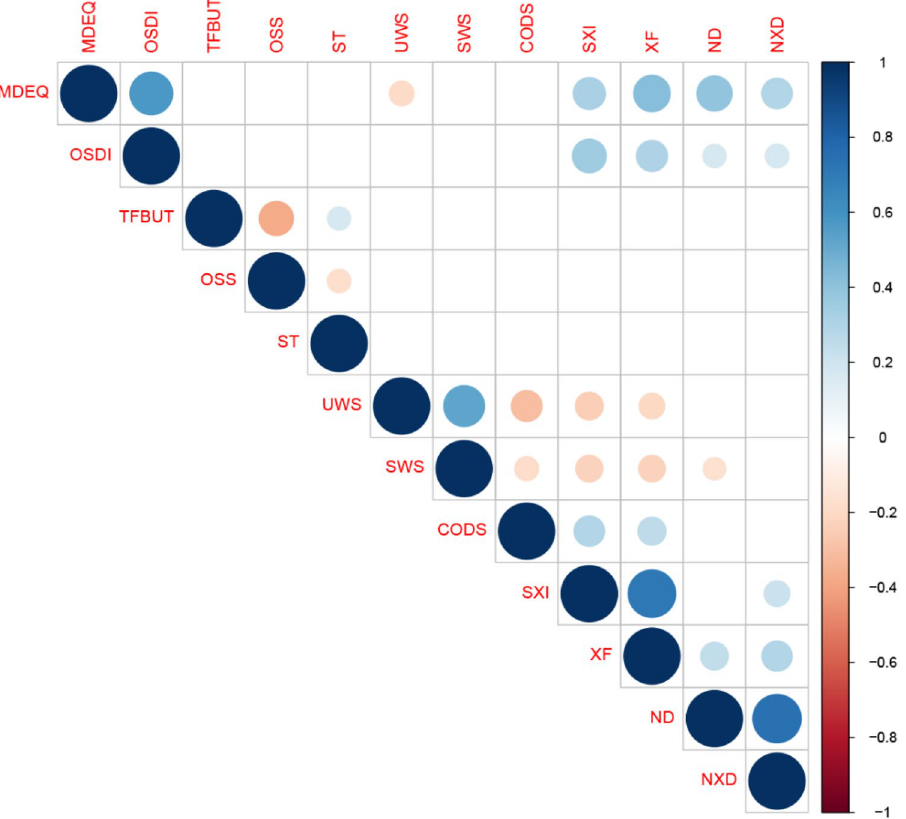
Figure 2. Significant correlations when comparing patient-reported and clinical ocular and oral findings (p < 0.05). Ocular parameters: MDEQ McMonnies Dry Eye questionnaire, OSDI Ocular Surface Index questionnaire, TFBUT tear film break up time (s), OSS ocular surface staining, ST Schirmer I test (mm/5 min). Oral parameters: UWS unstimulated whole saliva (ml/min), SWS stimulated whole saliva(ml/min),